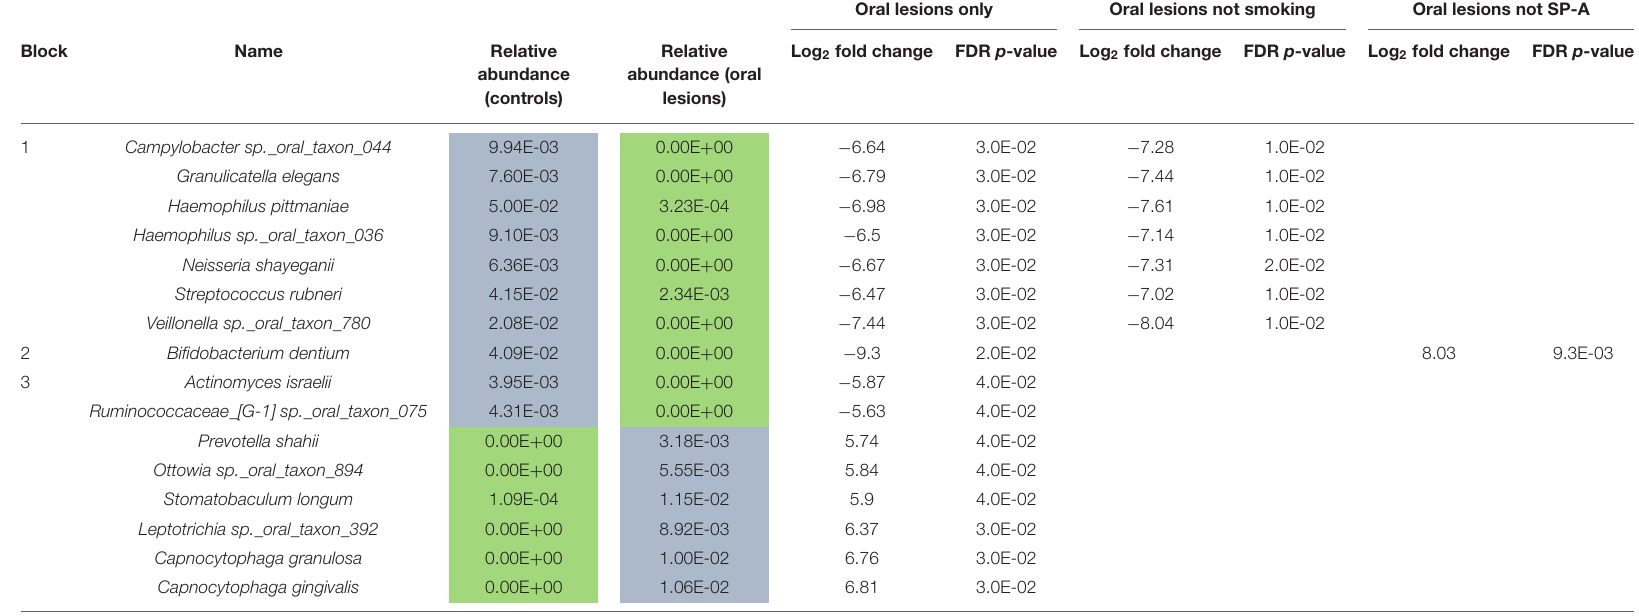
OTU best-matches are shown in the “Name” column. The next two columns display the relative abundance for control and oral lesions groups, with the higher value in blue and the lower value in green. The next two columns show the fold difference between lesions and controls, and the FDR p-value, with no removal of confounders. The final four columns identify if there are significant differences between oral lesions and controls after accounting for smoking and SP-A levels. The results fall in 3 blocks. Block 1 shows bacterial OTUs that are confounded by SP-A levels. Block 2 shows bacterial OTUs that are confounded by smoking. Block 3 shows OTUs confounded by smoking and SP-A